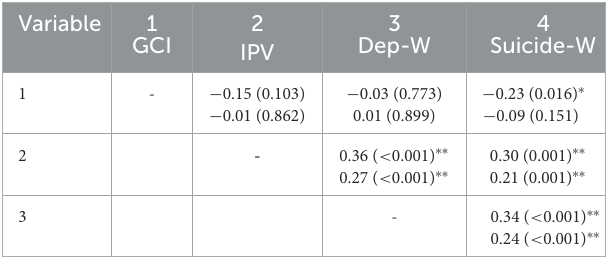
TABLE 3 Partial correlation analyses between individualism-collectivism, intimate partner violence, and mental health outcomes, controlled for confounding